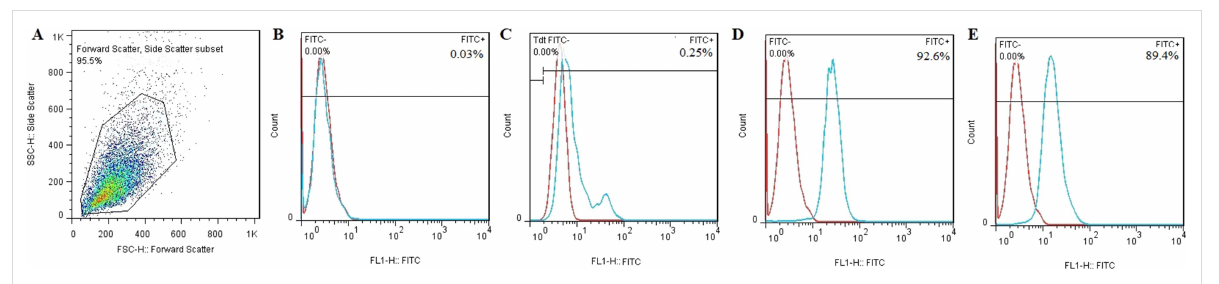
Figure 2: Phenotypical characterization of BM-MSCs by flow cytometry. (A) The cell population; The BM-MSCs were negative for (B) CD31 (0.03%) and (C) CD34 (0.25%) and positive for (D) CD44 (92.6%) and (E) CD90 (89.4%). Flow cytometry data was analyzed by FlowJo software (version 6.2).